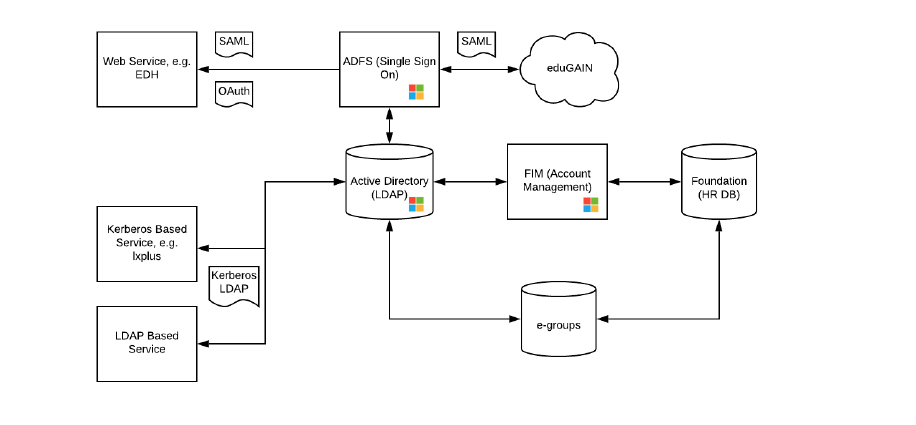
Figure 2. Previous, largely Microsoft-based architecture